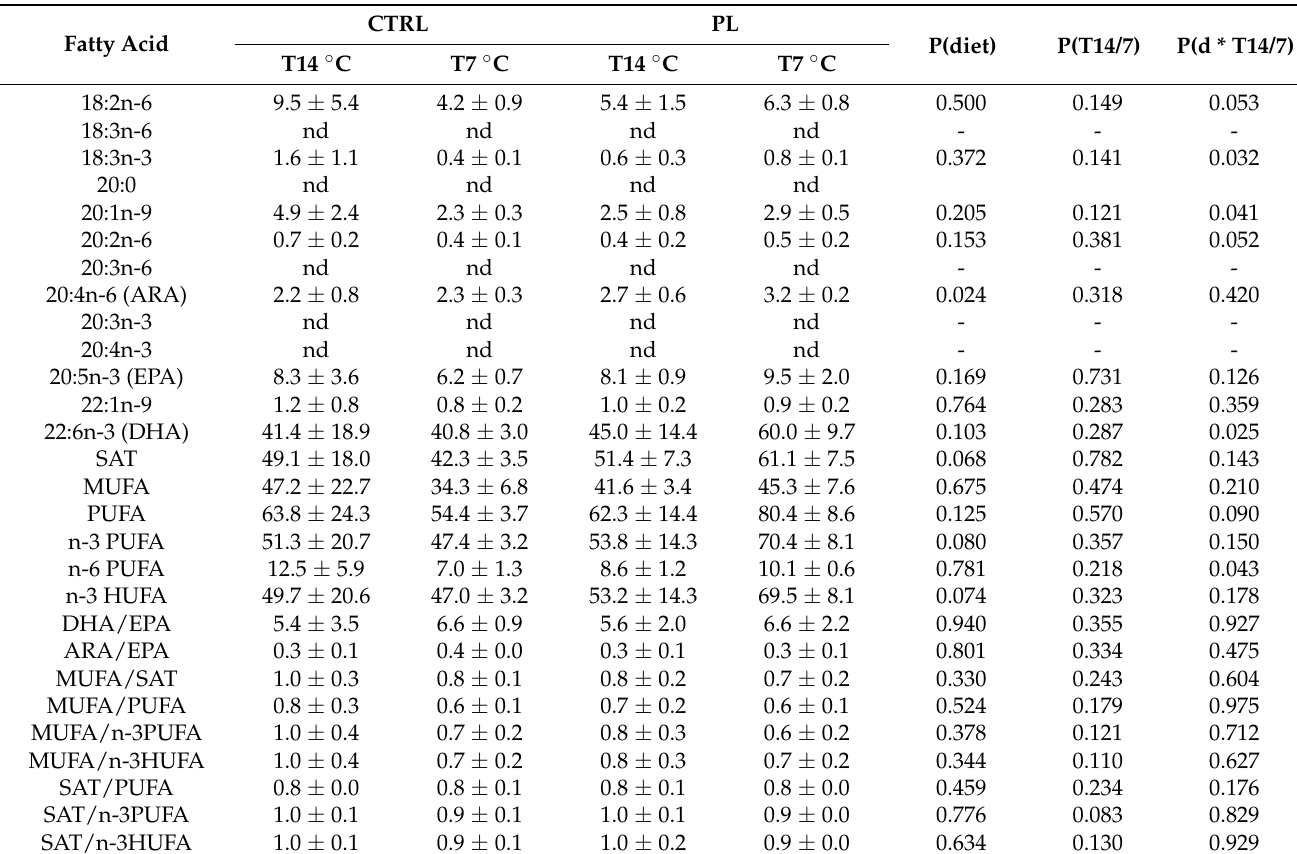
Figure 5. FA amounts in brain of animals fed with the control (CTRL, blue) or PL-enriched (PL, orange) diets. ( a ) Principal component analysis (PCA) plot based on FA composition (in µg FA mg dw − 1 ). ( b ) Brain content of FA significantly corre- lated with PC1: DHA; and PC2: 18:1n-9. Data were expressed as mean ± SD ( n = 4). Results of two-way ANOVA are presented in the square (T=temperature; diet=dietary treatment). Asterisk above bars indicates significant differences be- tween temperature treatments (t-test; p < 0.05). * p < 0.05; ** p < 0.01; *** p < 0.001. 4. Discussion Phospholipids are essential lipids that play a key role in somatic growth, survival, prevention of skeletal deformities and stress resistance in larvae and juveniles [38]. In this